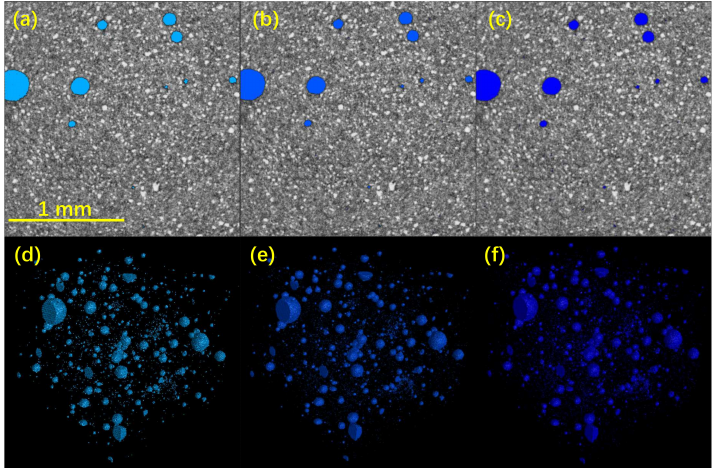
Figure 6. 2D ( a – c ) and 3D ( d – f ) images of pores segmented from paste skeleton at ( a , c ) low, ( b , d ) middle, and ( c , f ) high threshold values from Figure